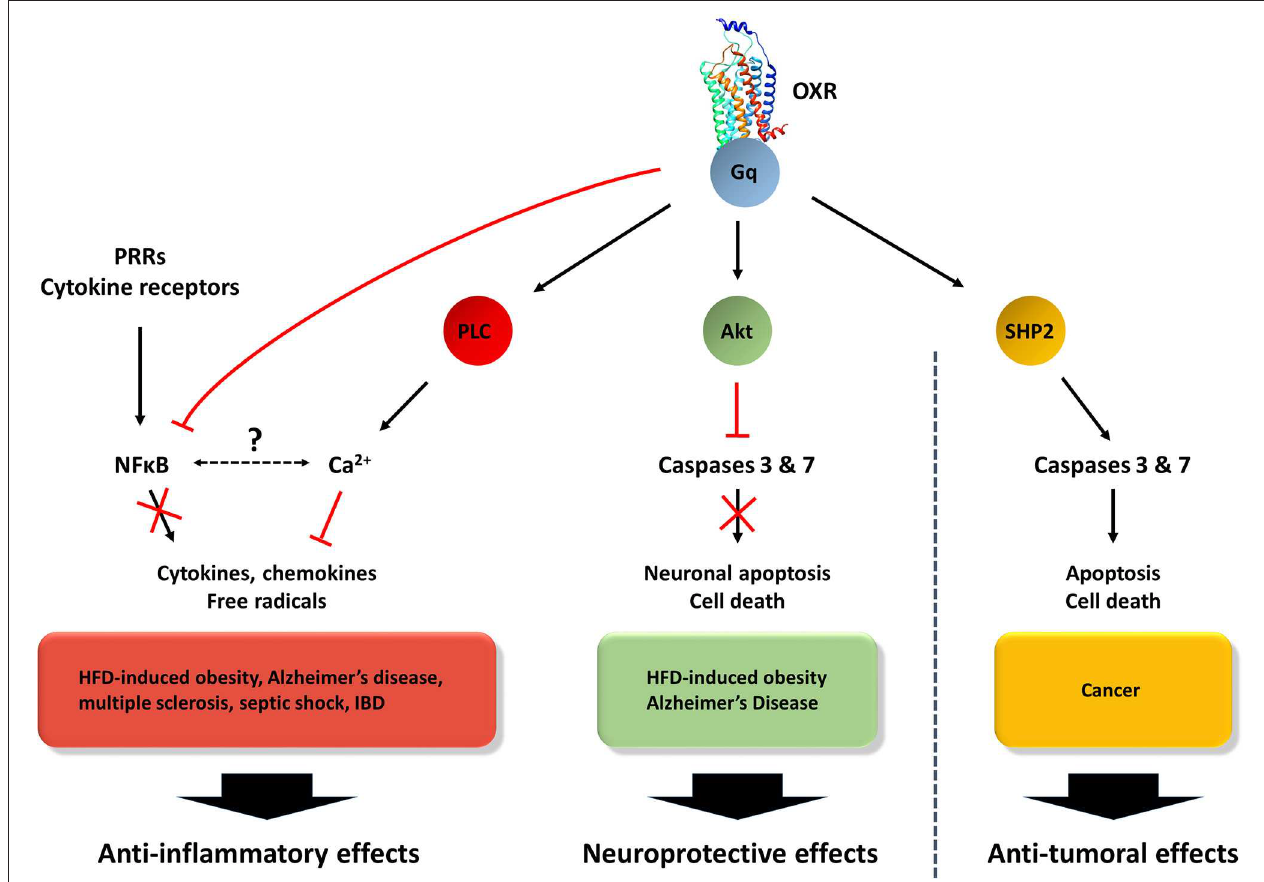
FIGURE 2 | Orexins/OXR system-modulated signaling patways involved in anti-inflammatory, neuroprotective and anti-tumoral effects. The orexin/receptors system may trigger: (1) anti-inflammatory functions through the inhibition of NF κ B and the activation of PLC/Ca 2 + pathways, (2) in the CNS, neuroprotective actions via the inhibition of caspases 3/7 by Akt pathway and (3) in the context of cancer, anti-tumoral effects through the activation of caspases 3/7 by SHP2 signaling pathway (